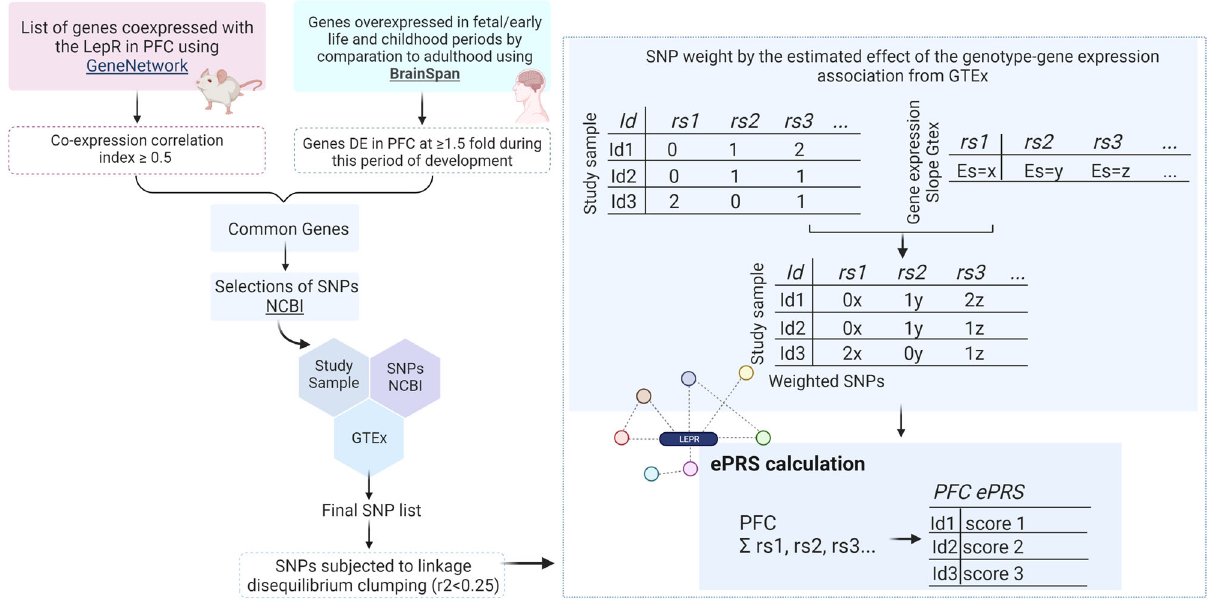
Fig. 4 Schematic presentation of the steps involved in the creation of the expression-based polygenic risk score based on genes co-expressed with the leptin receptor (LepR-ePRS). Schematic presentation of the steps involved in the creation the expression-based polygenic risk score based on genes co- expressed with the leptin receptor using the prefrontal cortex (PFC) based LepR-ePRS as an example. Genetic score for the leptin receptor gene network in the PFC: GeneNetwork database was used to generate a list of genes co-expressed with LepR in the PFC in mice. Then mice genes were converted to human orthologs. BrainSpan database was used to identify genes from this list with enrichment within the human PFC during early development. Since we were interested in gene networks that were active during early developmental periods, we retained only the genes overexpressed in early life in comparison to adulthood. Then, we gathered all the SNPs from these genes using the National Center for Biotechnology Information, and merged this list with